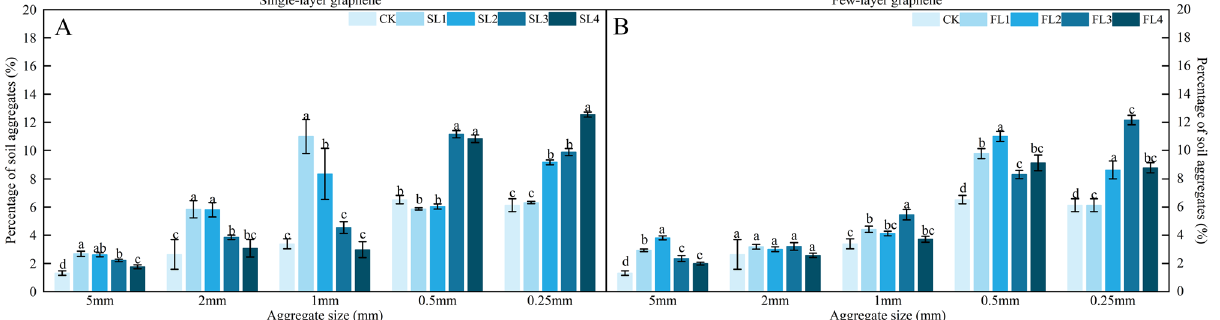
Figure 1. Effect of different graphene concentration and type on soil aggregate size distribution. CK. 0 g kg −1 single-layer graphene and 0 g kg −1 few-layer graphene; SL1 and FL1. 25 g kg −1 single-layer graphene and 25 g kg −1 few-layer graphene; SL2 and FL2. 50 g kg −1 single-layer graphene and 50 g kg −1 few-layer graphene; SL3 and FL3. 100 g kg −1 single-layer graphene and 100 g kg −1 few-layer graphene; SL4 and FL4. 150 g kg −1 single-layer graphene and 150 g kg −1 few-layer graphene; error bars indicate ± standard deviation. Different letters above error bars indicate significant difference between treatment (p < 0.05, LSD